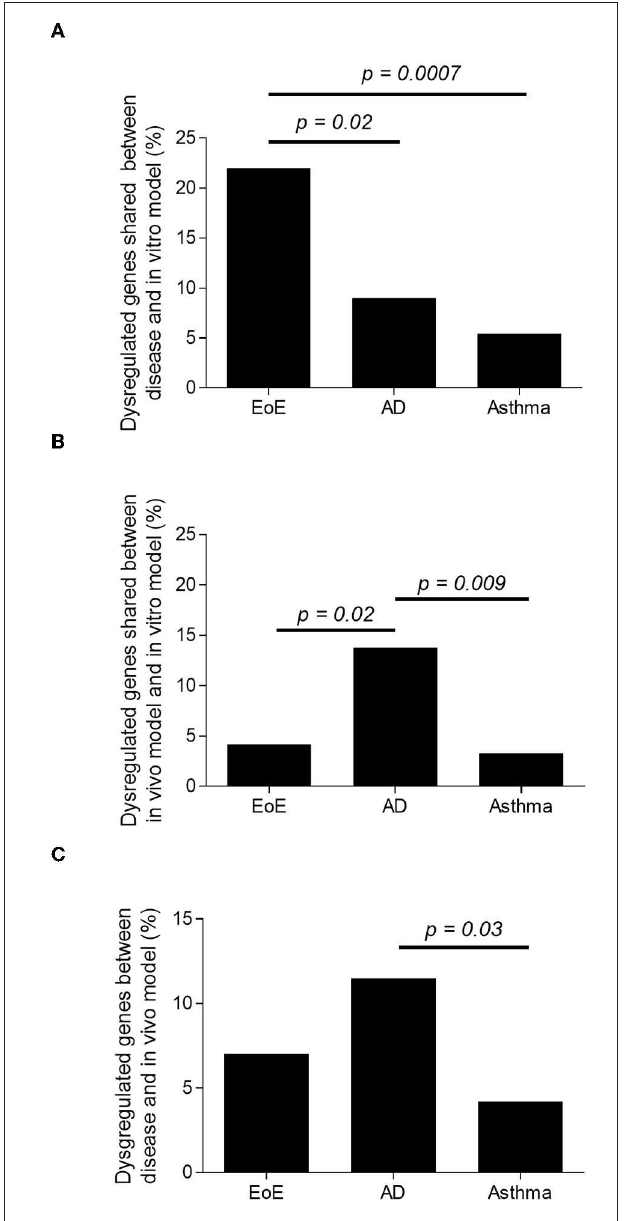
FIGURE 2 | Representation of IL-13–induced, epithelial cell-derived genes in the human disease and in the in vivo models. Percentage of dysregulated transcripts in EoE, AD, and AA human diseases. (A) Percentage of dysregulated transcripts shared between EoE, AD, and AA human disease and IL-13–treated human primary esophageal, skin, and nasal epithelial cells in vitro , respectively. (B) Percentage of dysregulated transcripts shared between EoE, AD and AA mouse model and IL-13–treated human primary esophageal, skin, and nasal epithelial cells in vitro , respectively. (C) Percentage of dysregulated transcripts shared between EoE, AD, and AA human disease and EoE, AD, and AA mouse model, respectively.